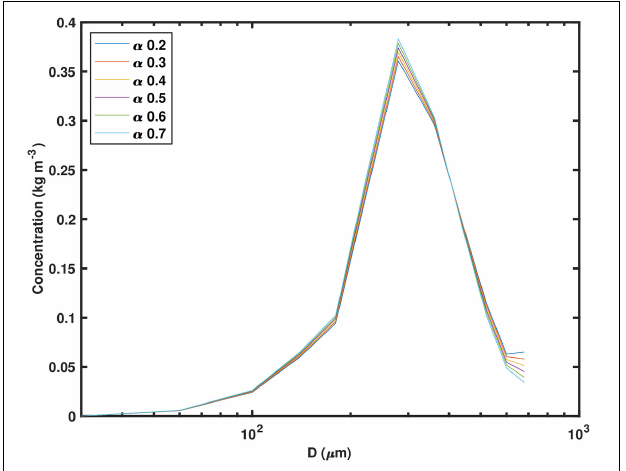
FIGURE 4 | Size distribution by mass concentration of OPA at the end of 2 h simulation calculated using different collision efficiencies (see legend). A fractal dimension of n f = 2 . 3 was used for these